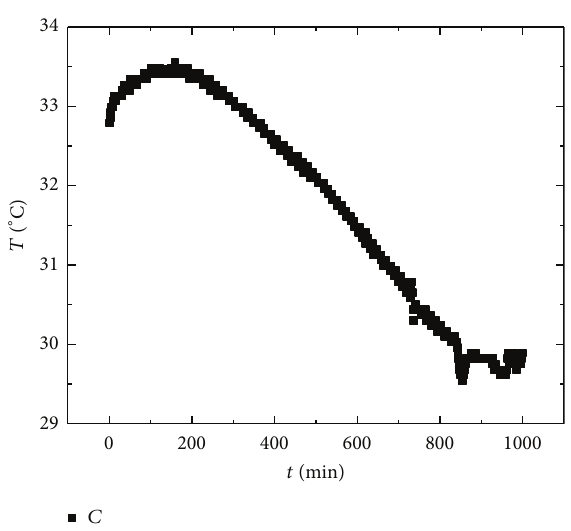
in a time span of 1000 minutes. out